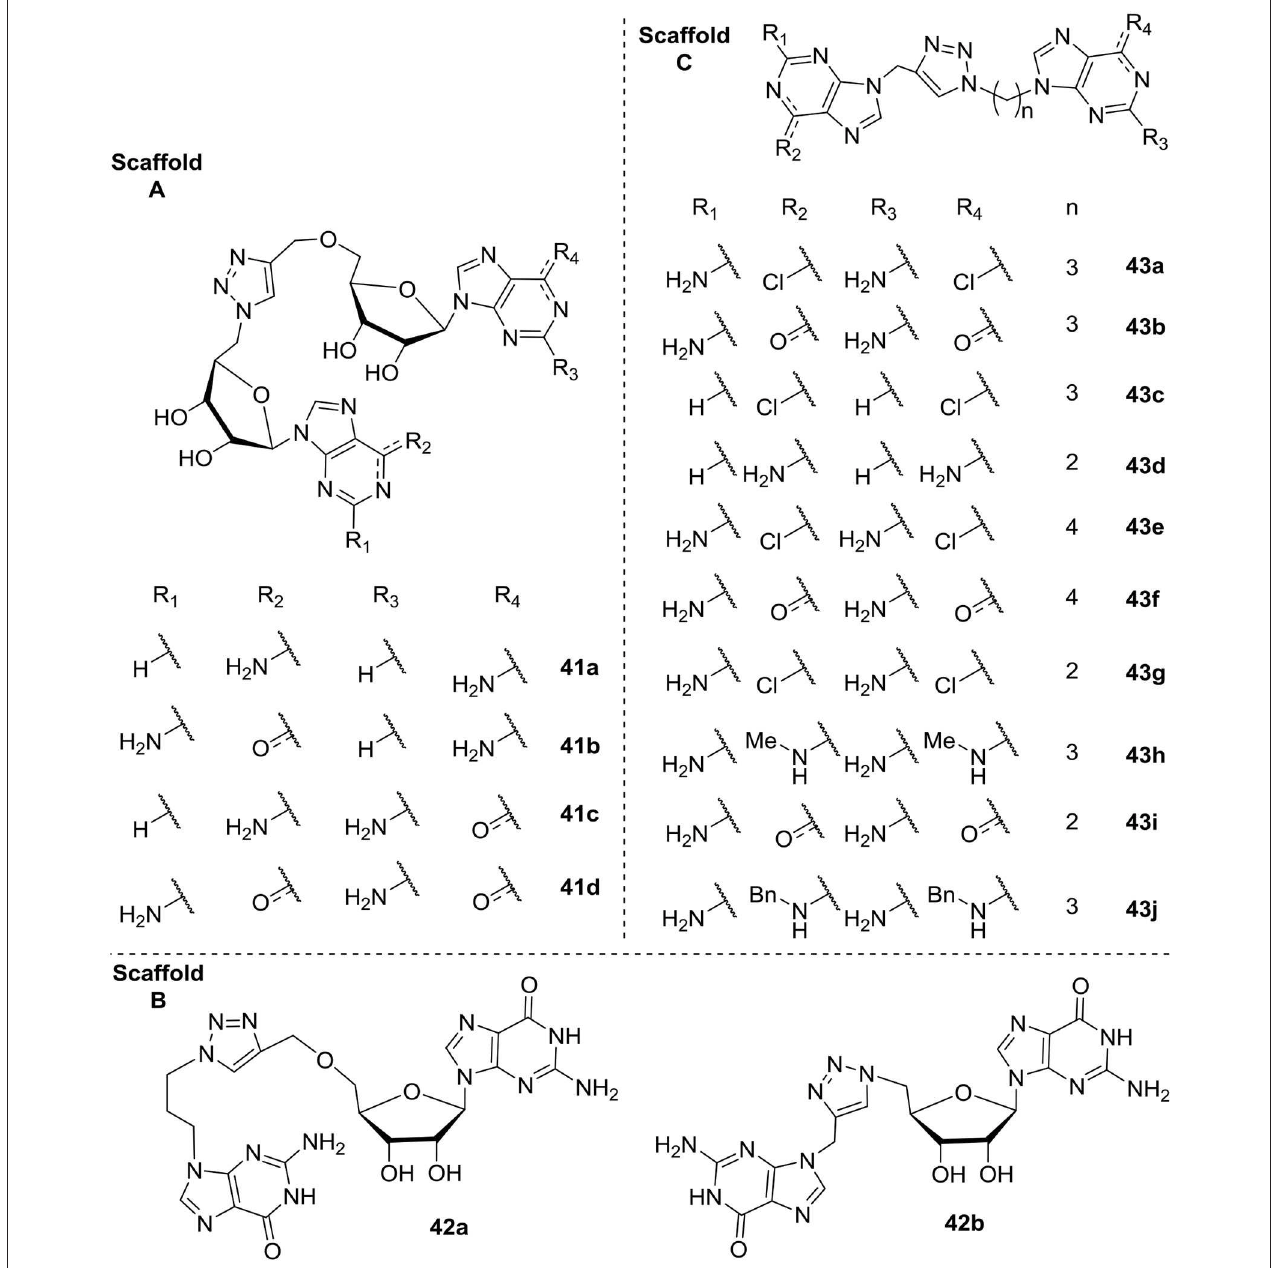
FIGURE 10 | C-di-GMP analogs, with a 1,2,3-trizole moiety incorporated, investigated for their allosteric inhibitory effect on DGC by Cutruzzolá et al. The analogs are grouped into three Scaffold types ( A–C ; Fernicola et al.,